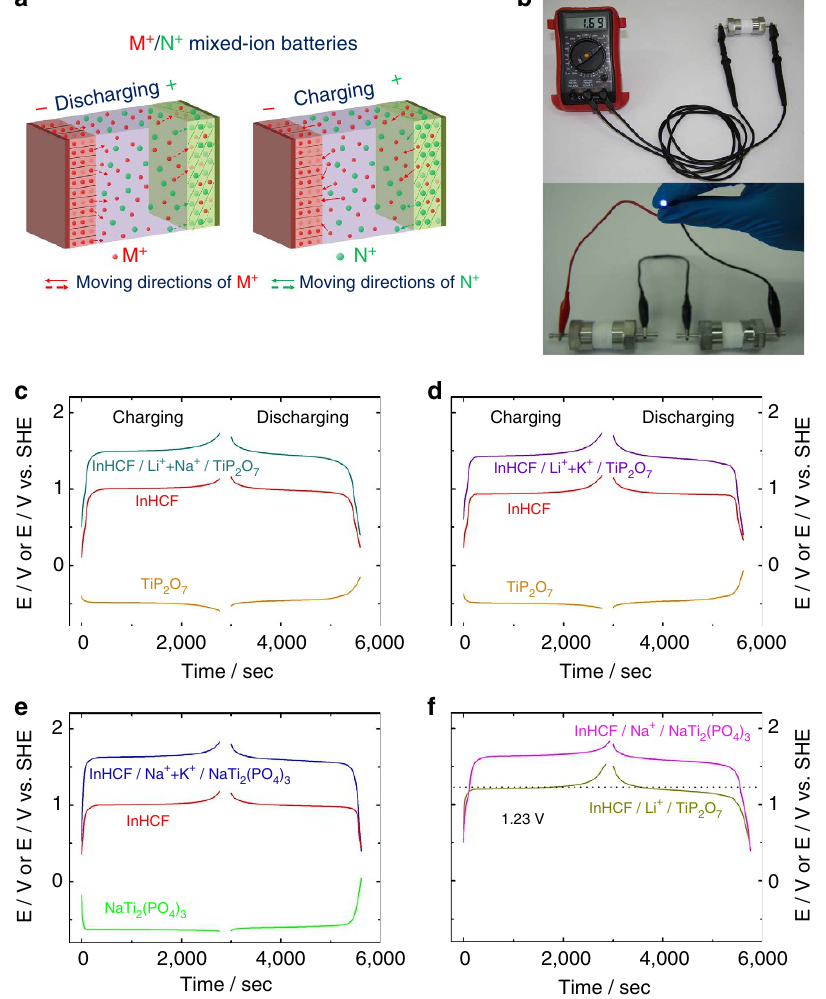
Figure 3 | Aqueous mixed-ion batteries. ( a ) A schematic of M þ /N þ aqueous mixed-ion battery. ( b ) Photos of InHCF/Na þ þ K þ /NaTi 2 (PO 4 ) 3 (B-III) battery in a Swagelok-type cell. One is connected with a voltage metre, and two in series are lighting up a 3-V blue LED. ( c – e ) Galvanostatic profiles of InHCF/Li þ þ Na þ /TiP 2 O 7 (B-I), InHCF/Li þ þ K þ /TiP 2 O 7 (B-II) and InHCF/Na þ þ K þ /NaTi 2 (PO 4 ) 3 (B-III) batteries along with the voltage profiles of their individual anode and cathode electrodes versus SHE at a rate of 1.5C. ( f ) Galvanostatic profiles of InHCF/Li þ /TiP 2 O 7 (B-IV) and InHCF/Na þ /NaTi 2 (PO 4 ) 3 (B-V) batteries measured at a rate of 1.5C. 1C ¼ 60mAg (cid:2) 1 .